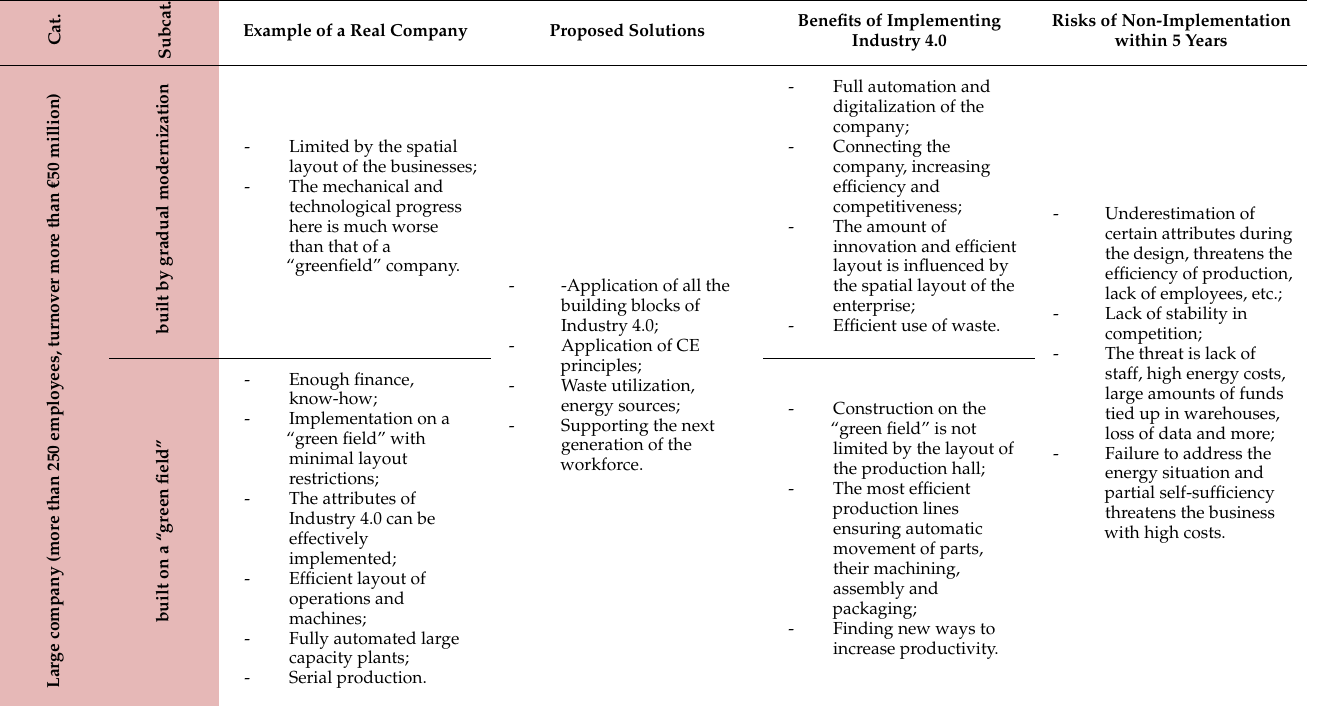
Table 7. Main results and recommendations (scored) for large enterprises and their subcategories ( n =